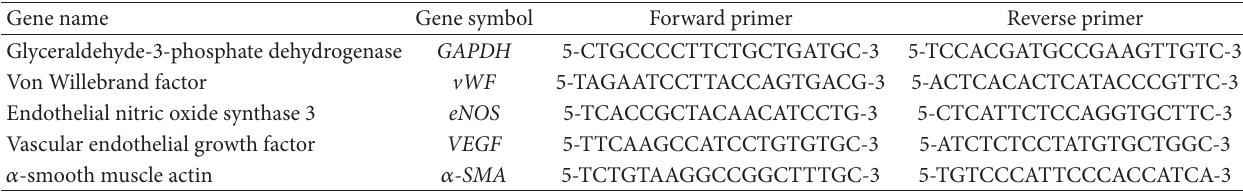
Table 1: Primer sequences used for real-time